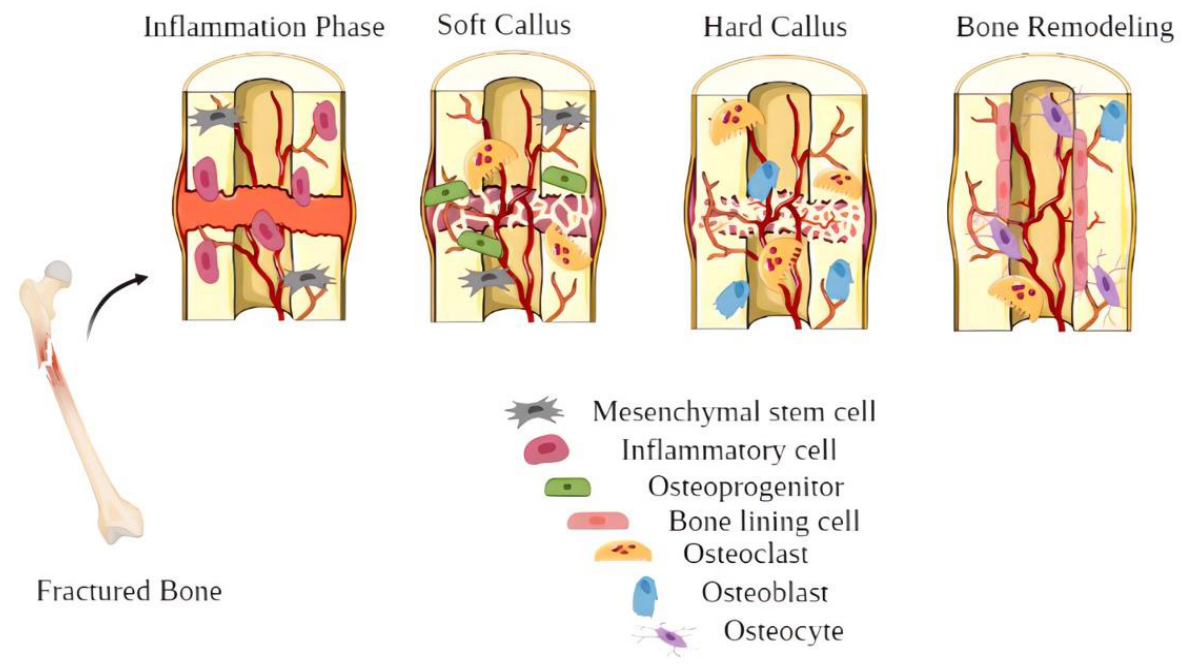
Figure 1. Illustration of the bone healing process.